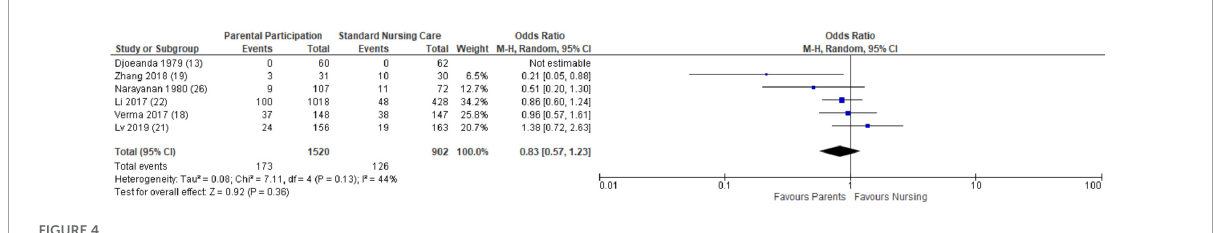
FIGURE4 Forest plot and meta-analysis of the association between parental participation and nosocomial infection.